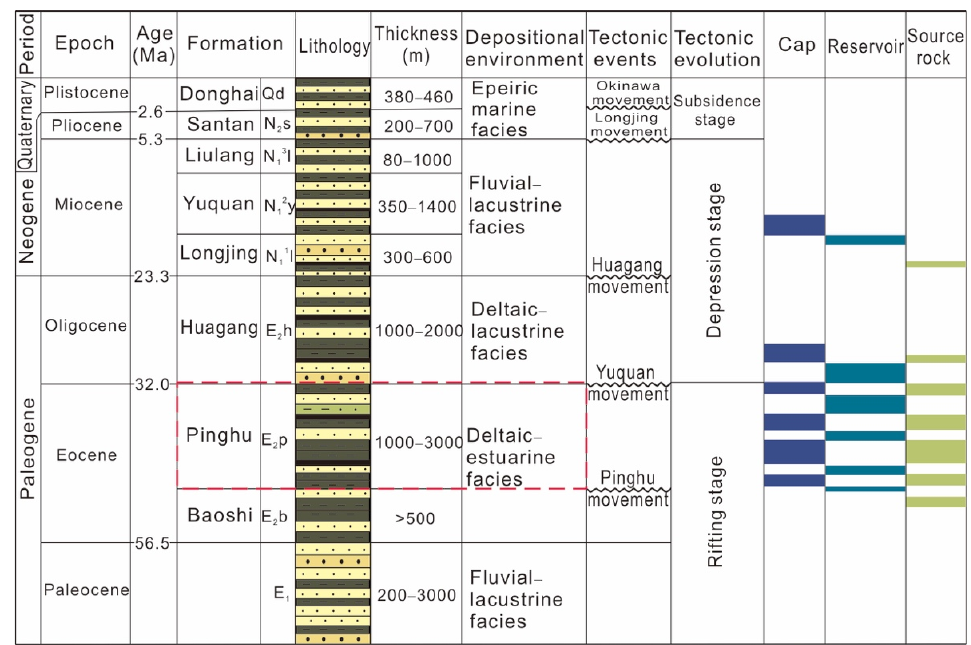
Figure 2. Generalized Cenozoic stratigraphy of the Xihu Sag, East China Sea Basin. The dashed red rectangle shows the present study interval (Eocene–Oligocene Pinghu Fm., adapted with permission from [48–52]. 2012, Zhu et al; 2018, Su et al; 2022, Quan et al).